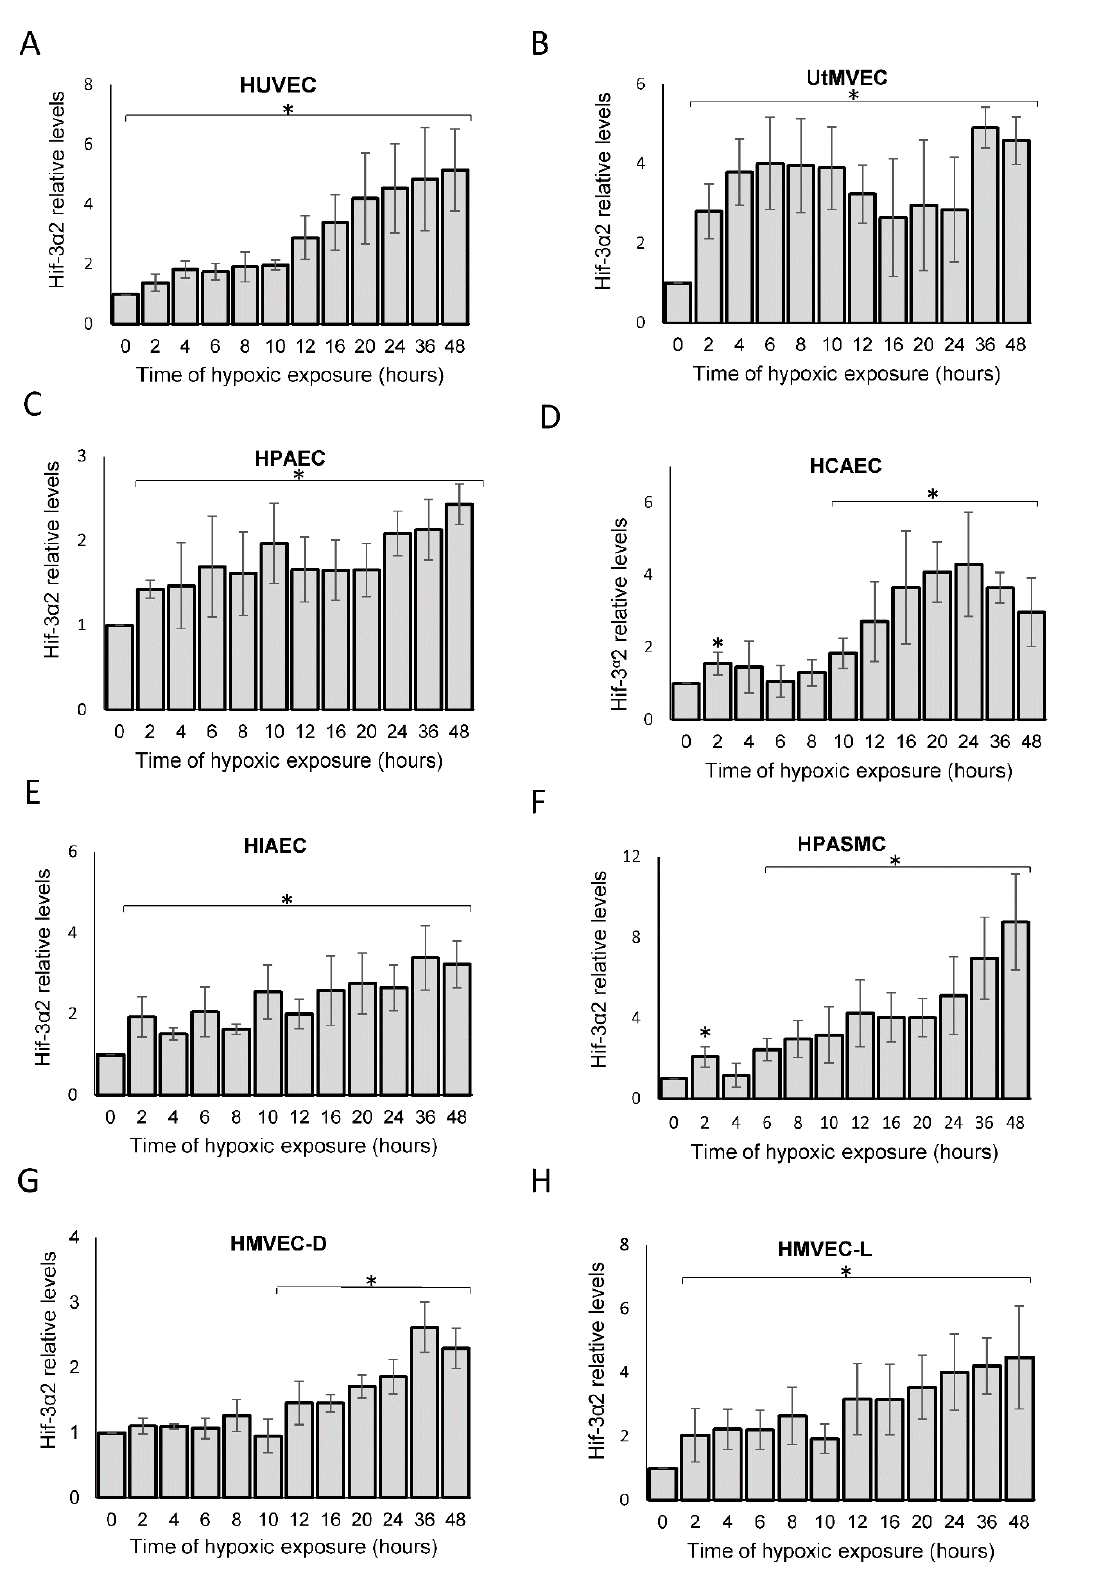
Figure 2: The densitometry analyses of the hypoxic changes in HIF-3α2 levels in human endo- thelium during hypoxia . The changes in HIF-3α2 protein levels were evaluated by western blot nor- malized to β-actin and total protein levels and expressed as a fold change over the normoxic control. Data represent the mean ± SD of three independent experiments. * P < 0.05 was considered significant. The raw data are presented in Supplementary data